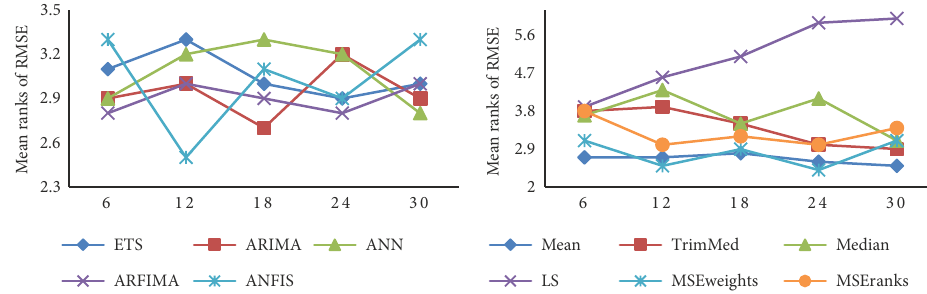
Fig. 3. Graph of the mean ranks of the methods for five forecasting horizons